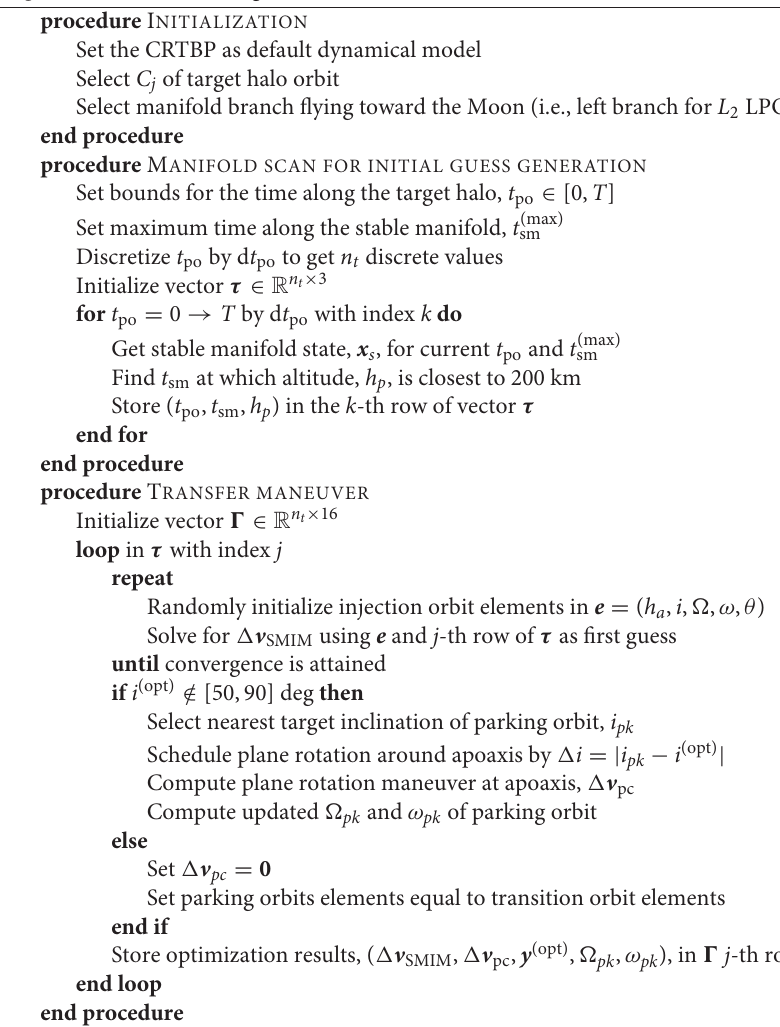
Algorithm 1 Transfer